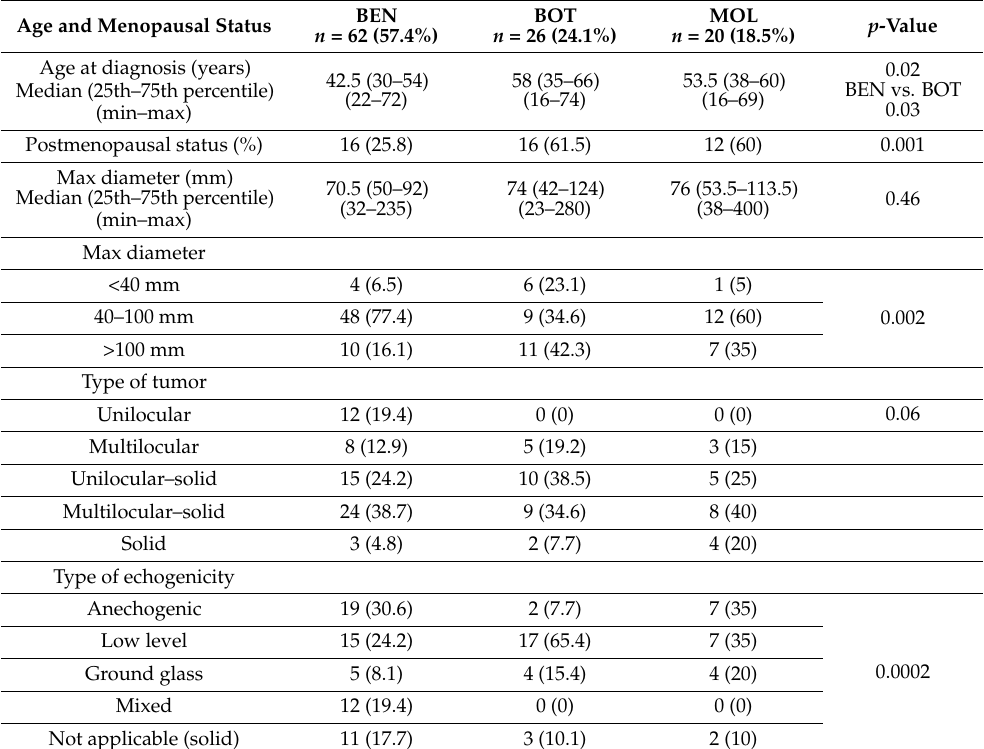
Figure 5. Color Doppler imaging of a small (35 mm in the maximum diameter) cystic–solid lesion with the central vascularization of a papillary projection and a solid part. The final histology revealed early stage invasive serous ovarian cancer. Table 2. Age and menopausal status of the studied women with sonographic characteristics of complex adnexal